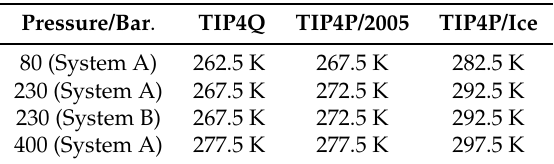
Figure 11. Final configurations of system A at P = 230 bar and two temperatures, ( a ) T = 290 K and ( b ) T = 300 K, where it can be seen that the former resulted in complete formation of the hydrate, whereas the latter yielded a liquid-like geometry. Table 3. Three-phase coexistence temperature (T 3 /K) determined for the three water models at different